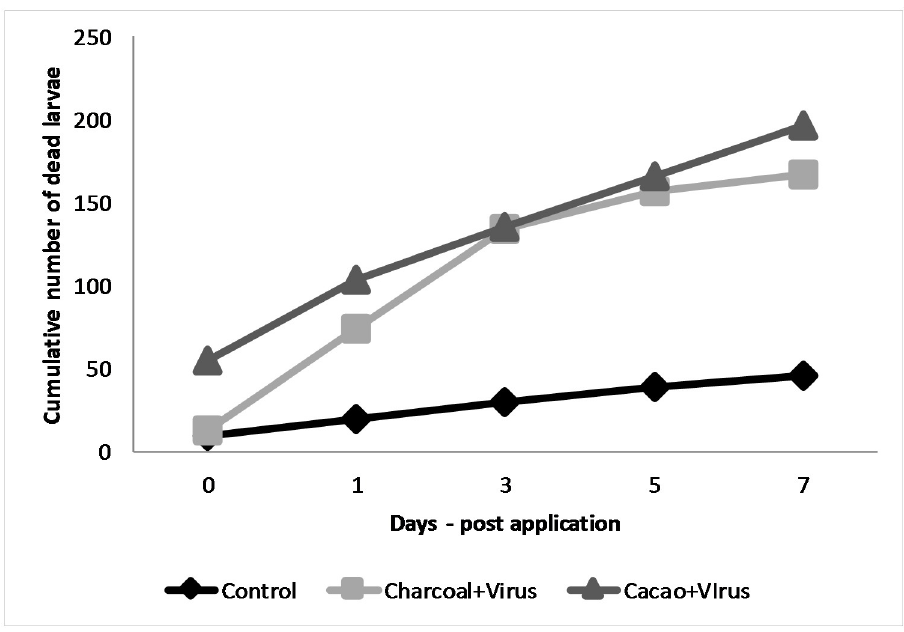
Fig 6. Cummulative larval mortality